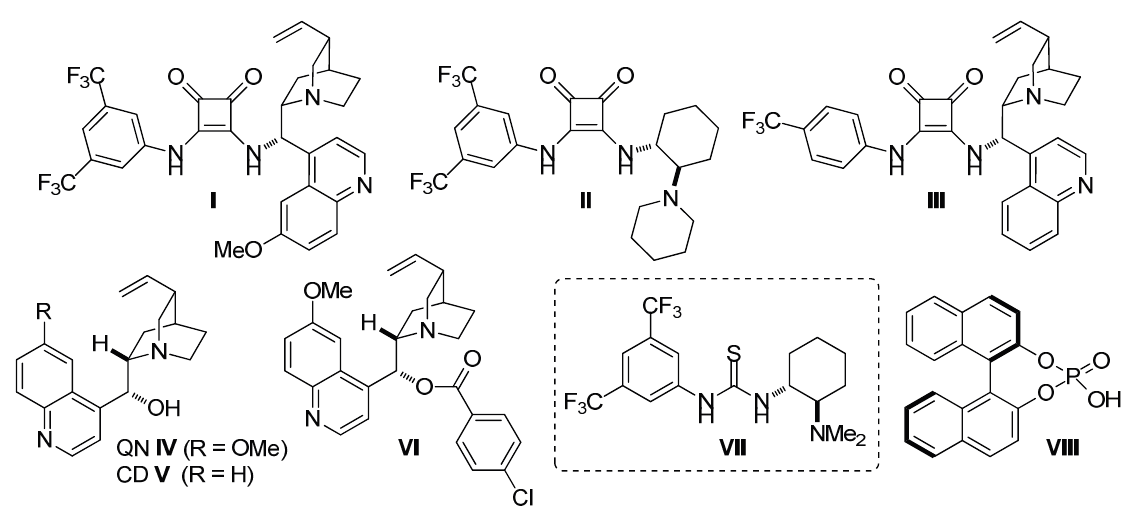
Figure 2. Model organocatalysts tested ( I – VIII